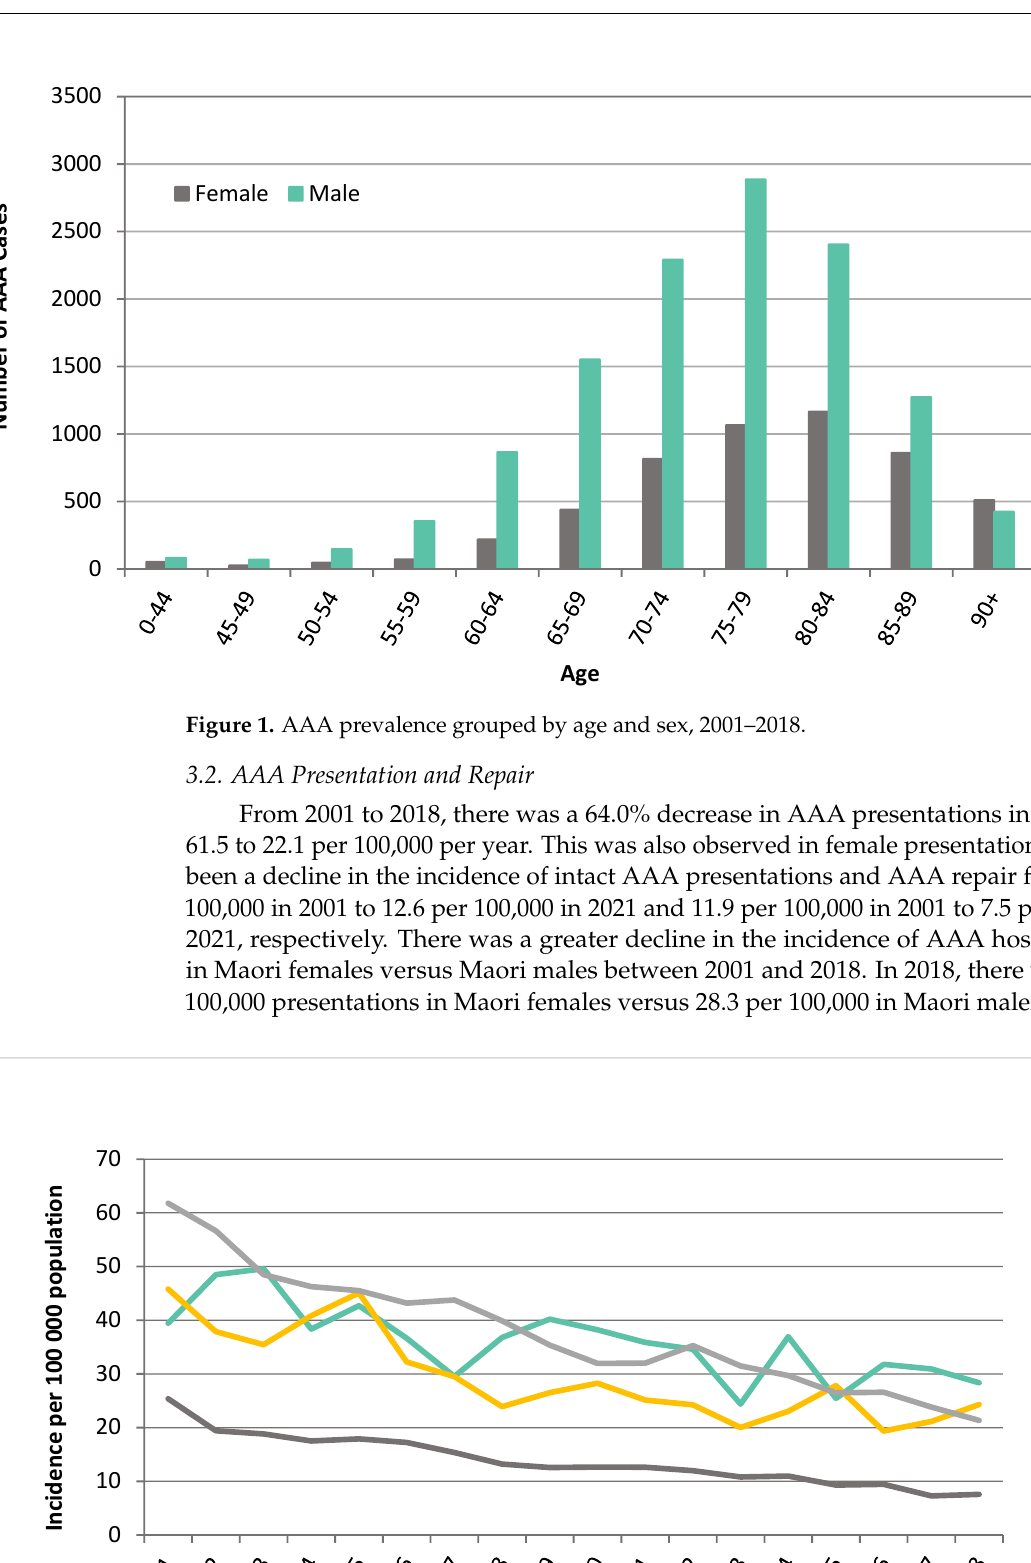
Figure 3. Trends in AAA presentation and management. † Pre-hospital rupture data available only from 2001 to 2018.